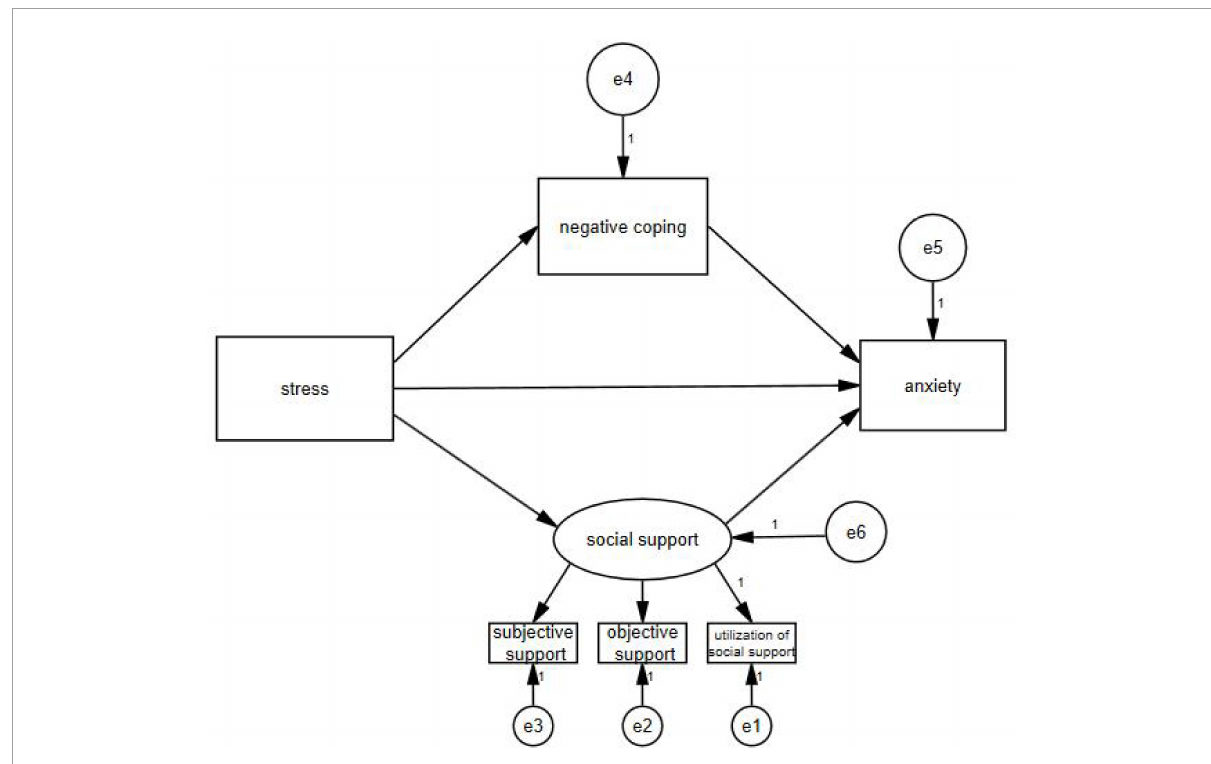
FIGURE1 Final structural equation model on anxiety. e1–e6: the sign of the measurement error.